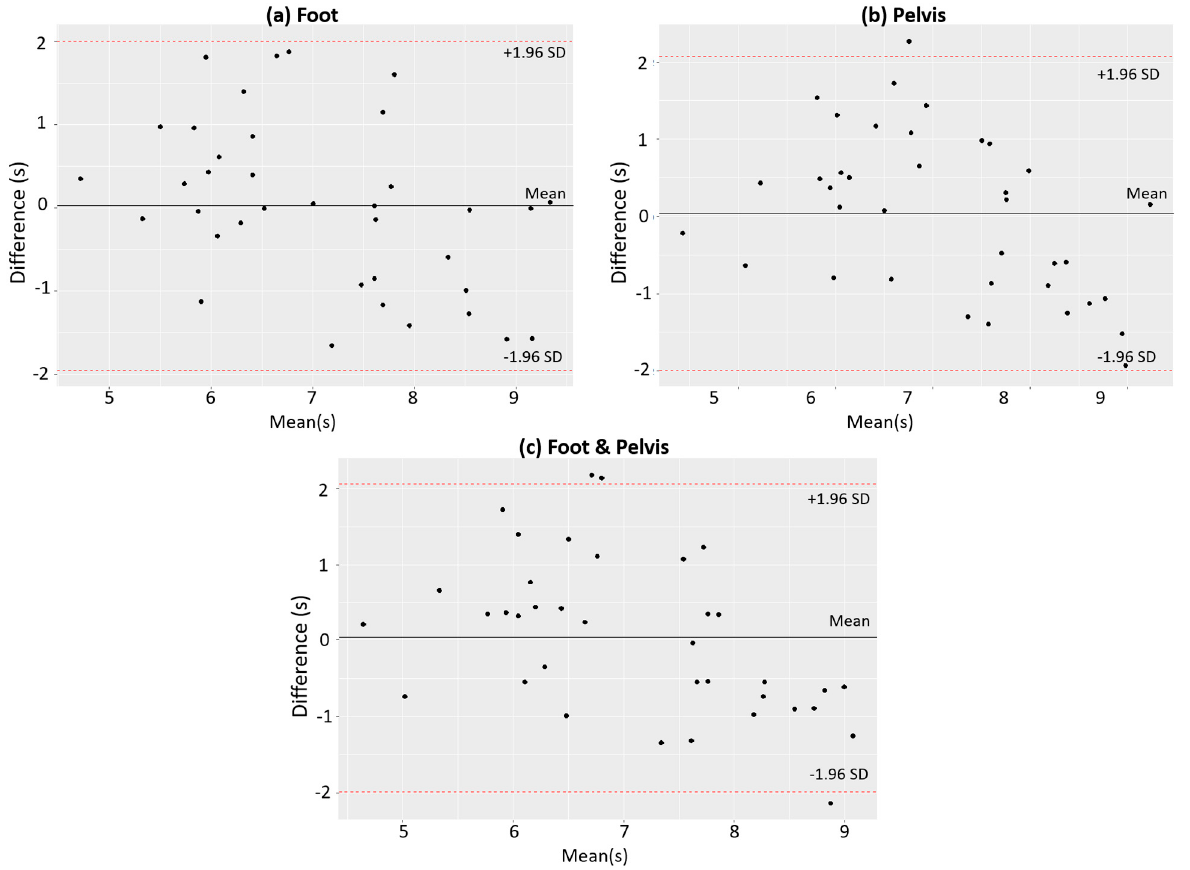
Figure 7. Bland–Altman plot comparing predicted TUG and actual TUG: ( a ) foot, ( b ) pelvis, and ( c ) foot and pelvis. The 95% limits of agreement are shown as two red dotted lines. Table 8. Comparison of Prediction Errors. No.